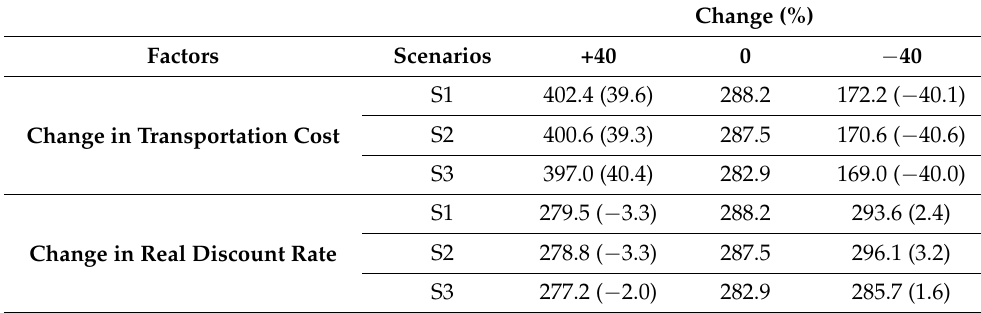
Table 4. Sensitivity analysis of the total cost of wood procurement (million USD) by changing the transportation cost and real discount rate by ±40%. Values reported are the average of 40-years of the simulation period. Values reported in parentheses are percentage changes from the base values. A higher discount rate has an inverse relation with NPV. With a decrease in NPV, rotation age also decreases, causing a decrease in the transportation cost.